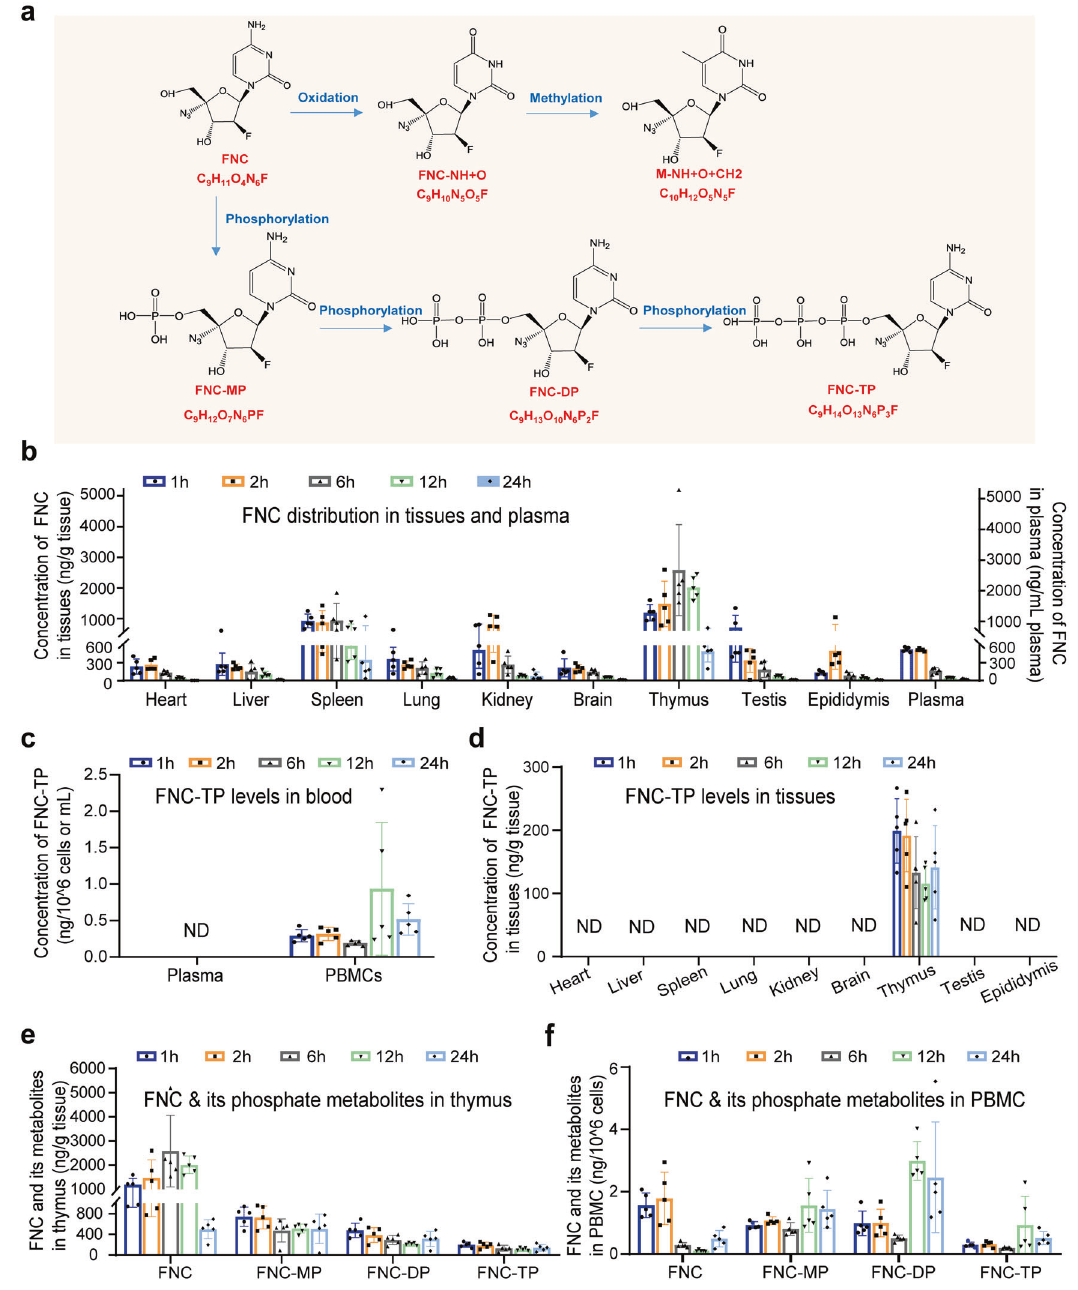
Fig. 2 Thymus-homing distribution and metabolism of FNC after oral administration in rats. Twenty- fi ve male Sprague – Dawley rats were orally administered with FNC at a single dose of 5 mg/kg. At the time point of 1, 2, 6, 12, and 24 h after drug administration, 5 rats were dissected. The blood, as well as the heart, liver, spleen, lung, kidney, brain, thymus, testis, and epididymis, were collected. Peripheral blood mononuclear cells (PBMCs) were isolated from blood using Histopaque-1083. The distribution of FNC in plasma, PBMCs, and the different tissues was evaluated through UHPLC – MS/MS analysis performed on an UHPLC system (1290 series, Agilent Technologies, USA) coupled to a triple quadrupole mass spectrometer (Agilent 6470 QQQ). a Metabolic pathway of FNC. b FNC distribution in tissues and plasma (5 mg/kg, oral). c FNC-TP levels in the blood (5 mg/kg, oral). d FNC-TP levels in tissues (5 mg/kg, oral). e FNC and its phosphate metabolites (FNC-MP, FNC-DP, and FNC-TP) in the thymus (5 mg/kg). f FNC and its phosphate metabolites in PBMCs (5 mg/kg). ND not